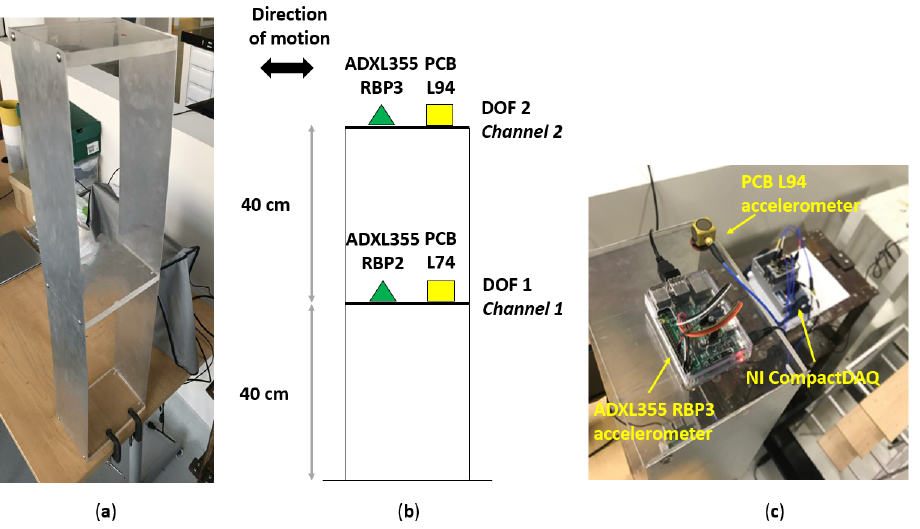
Figure 5. Flexible structure monitoring: ( a ) Two-story flexible structure. ( b ) Experimental setup. ( c ) Location of measurement channel